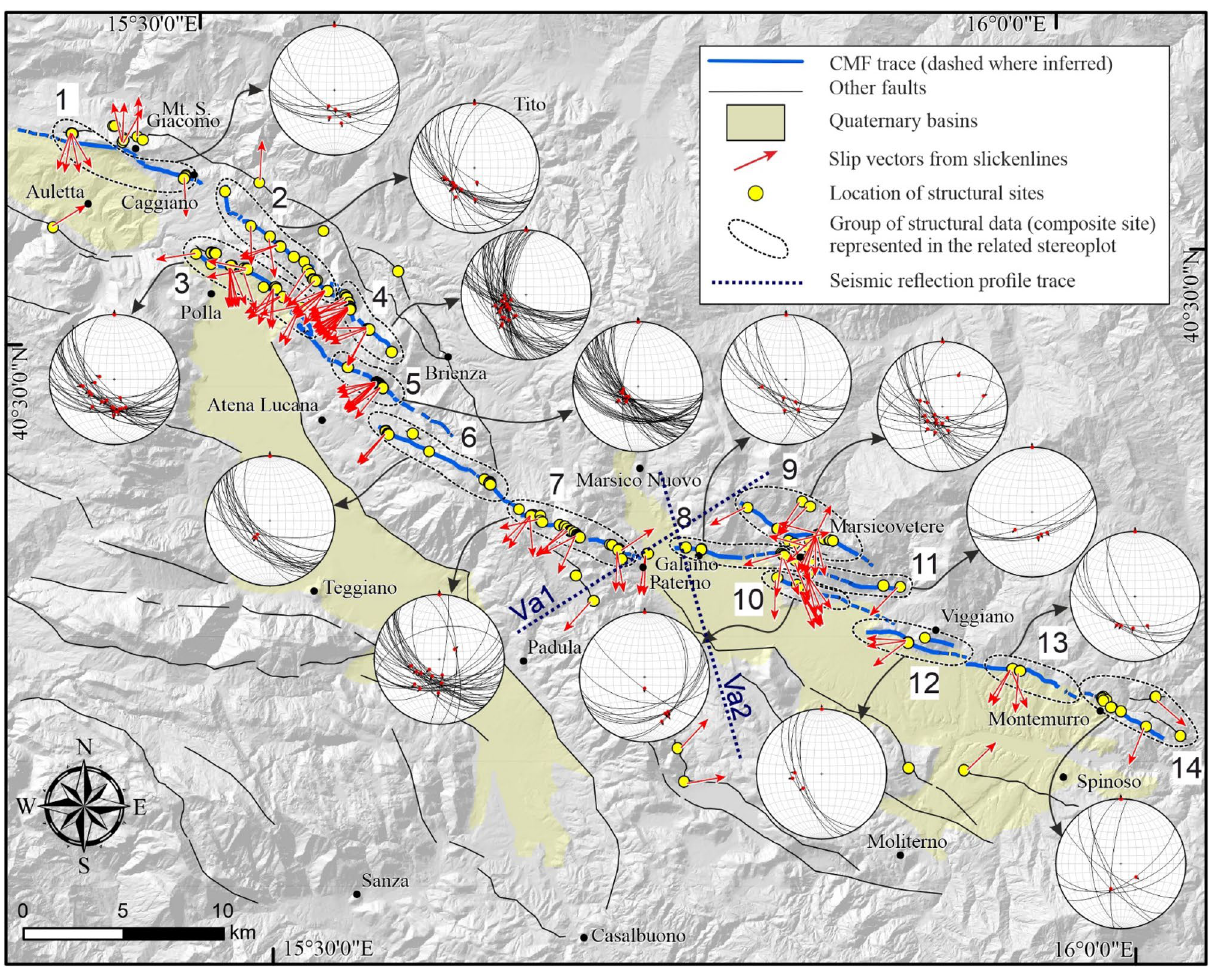
Figure 3. Structural map with survey sites (yellow circles) and slip vectors (red arrows). Location of the study area is in Fig. 1A. Stereoplots refer to groups of sites, delimited in the map by black dashed lines. Dark blue dotted lines are the trace of the two seismic reflection profiles interpreted in this